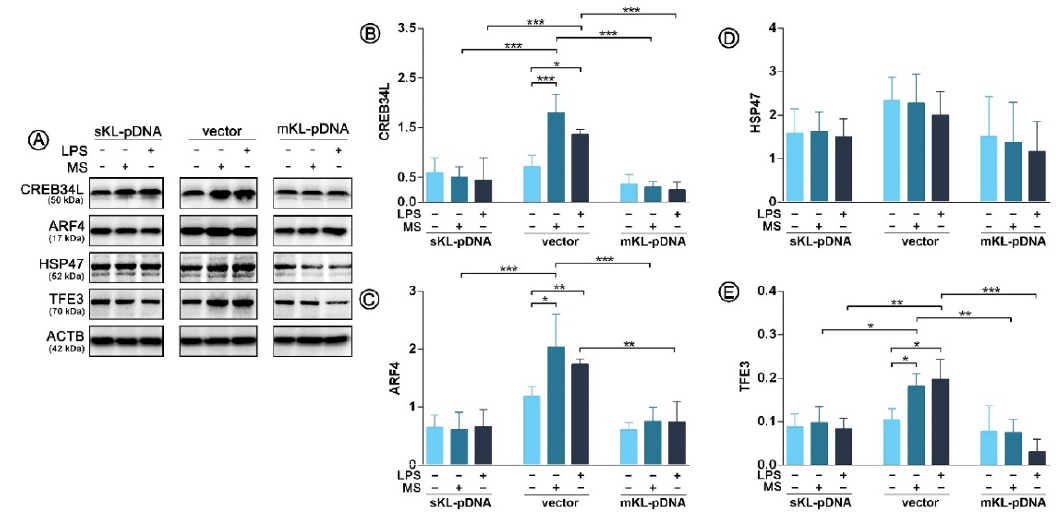
Figure 2. Expression of proteins involved in the Golgi stress response. Klotho expression was upregulated with pDNA, cells were treated for 72 h with monensin sodium or 168 h with LPS and expression of proteins involved in CREB34L-, HSP47- and TFE3-mediated pathways was evaluated with Western Blot method ( A ), i.e.,: CREB34L ( B ), ARF4 ( C ), HSP47 ( D ), and TFE3 ( E ). The bands were quantified and normalized to their corresponding β -actin bands. Bars indicate SD, n = 3, *** p < 0.001, ** p < 0.01, * p < 0.05, no indication – no statistical significance (one-way ANOVA and Dunnett’s a posteriori test).